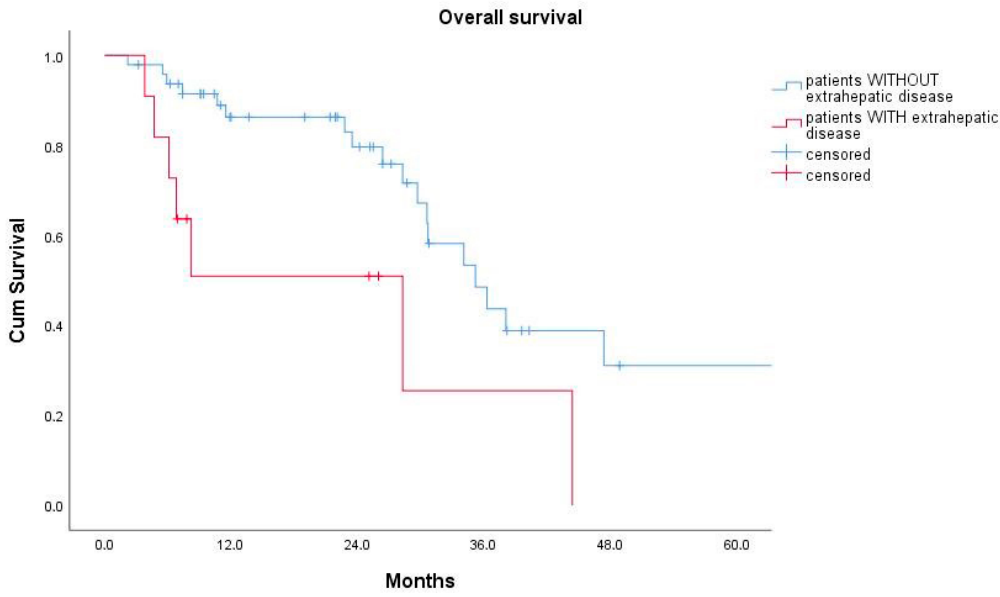
Figure 4. Kaplan–Meier curves for overall survival for patients without (blue) and with (red) evidence of limited extrahepatic disease on pre-interventional imaging. Table 3. Results of the univariable Cox regression analysis for overall survival. CEA: carcinoembryogenic antigen, PVE: portal vein embolization.